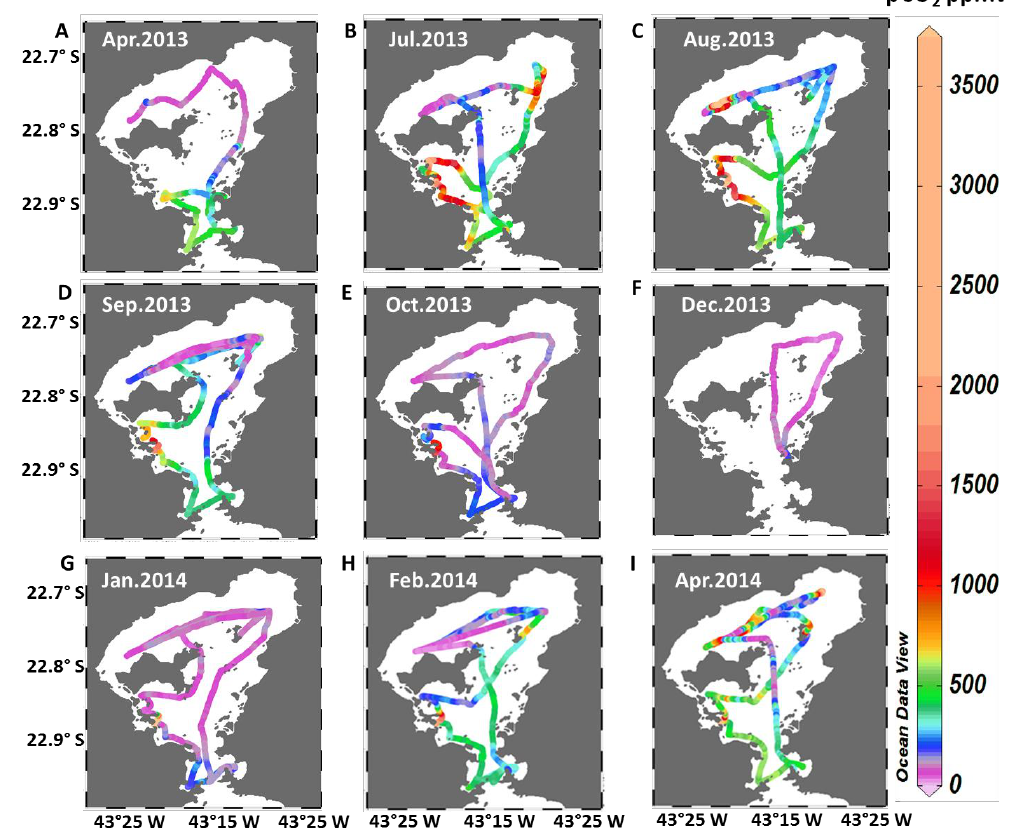
Figure 4. Concentration maps of continuous p CO 2 measurements in surface waters of Guanabara Bay for all the sampling campaigns.